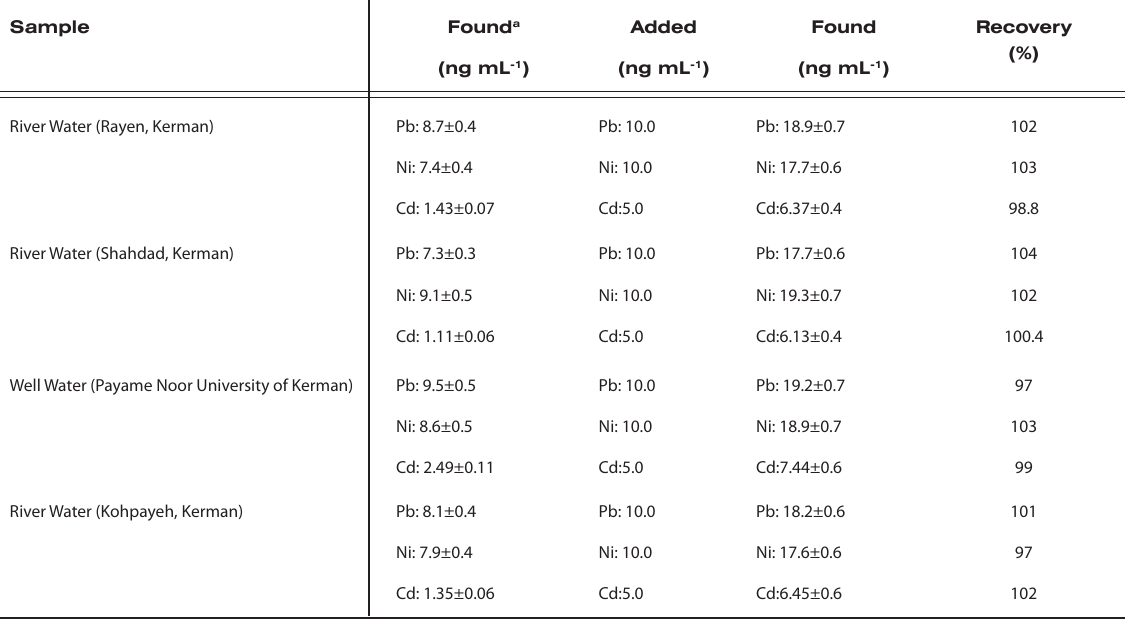
Table 7. Analysis of Pb(II), Ni(II) and Cd(II) ions in water samples Sample Found a